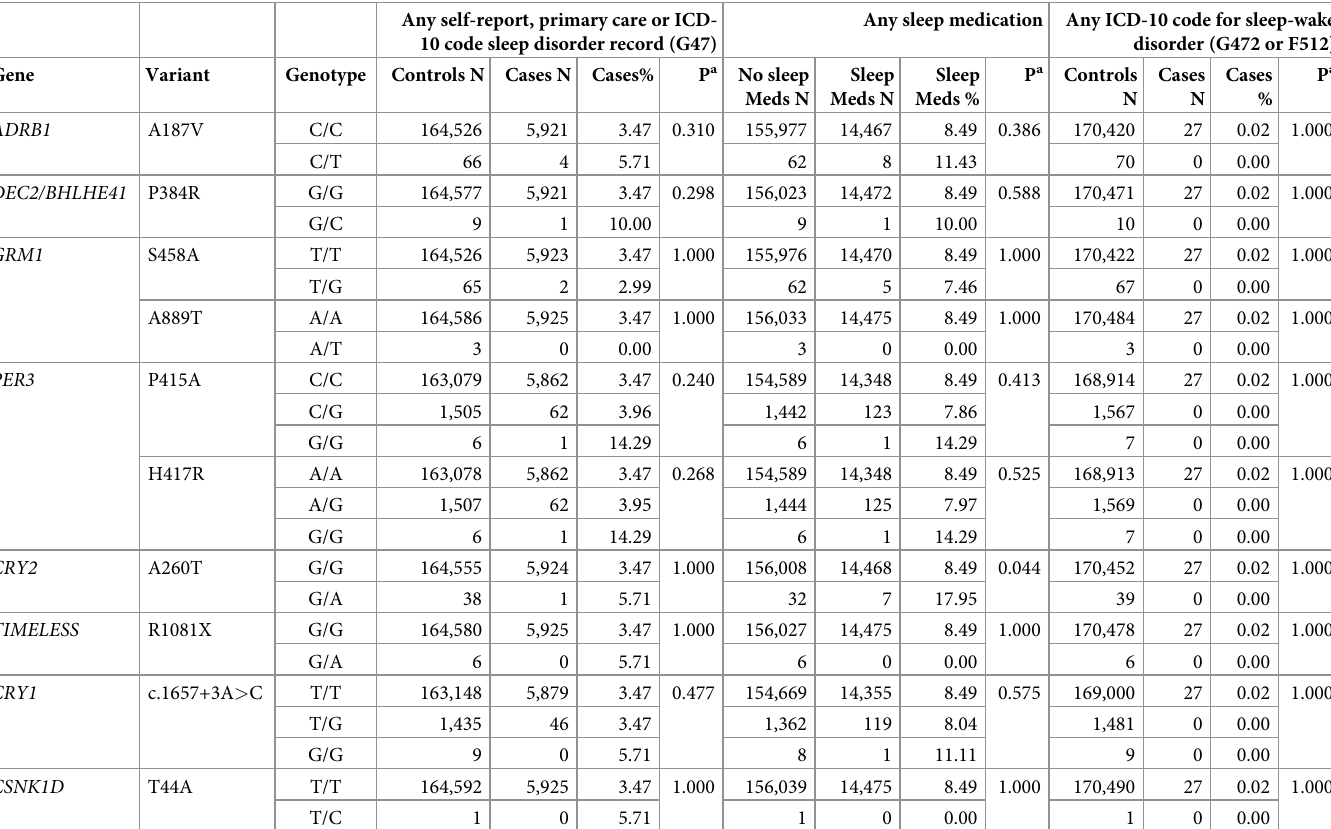
Table 1. Sleep disorder and medication status by carrier status of variants previously reported to affect sleep duration or timing. Sleep disorders in the UK Biobank coded as G47 from self-report, ICD-10 codes or primary care data. Also presented are results for disorders of the sleep wake cycle (ICD10: G472, F512). Sleep medication codes reported at UK Biobank baseline at reported in Lane et al . Nature Genetics,